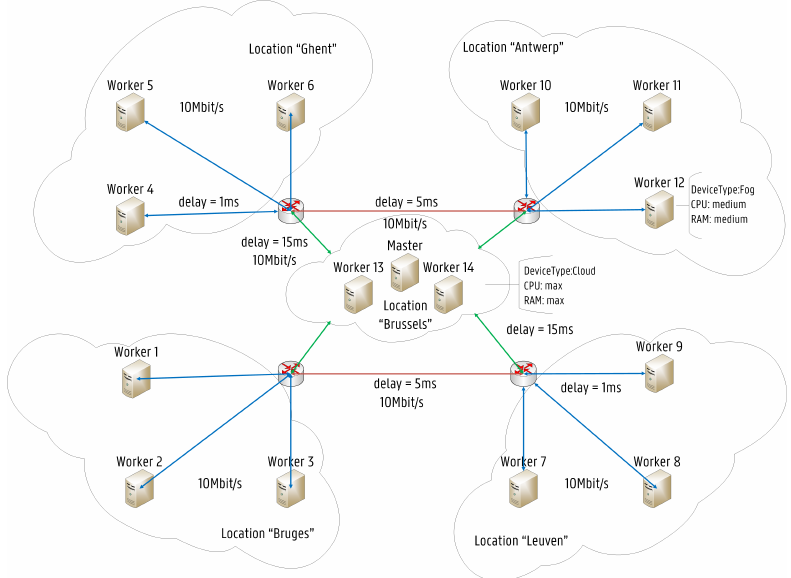
Figure 9. A Fog Computing infrastructure based on the Kubernetes